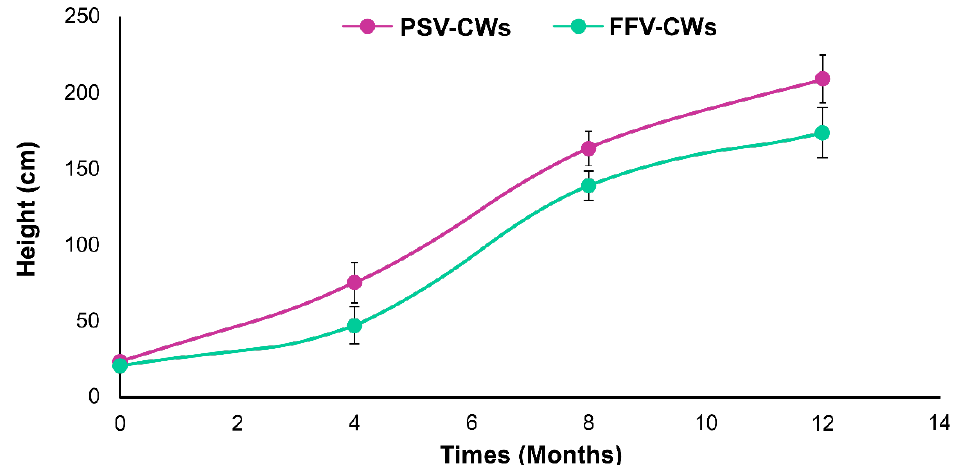
Figure 12. Growth of Heliconia latispatha during the 12 months of experimentation. The biomass produced at the end of the study period can be seen in the Table 4. The results indicated higher biomass growth in the PSV-CWs with a final total biomass of 5696.7 g/m 2 in dry weight, higher by 11.6% than those grown in the FFV-CWs. Table 4. Root and total aerial biomass produced in plants (grams in dry weight per m 2 ). CWs Biomass Aerial Biomass Root Total Biomass PSV-CWs 2342.4